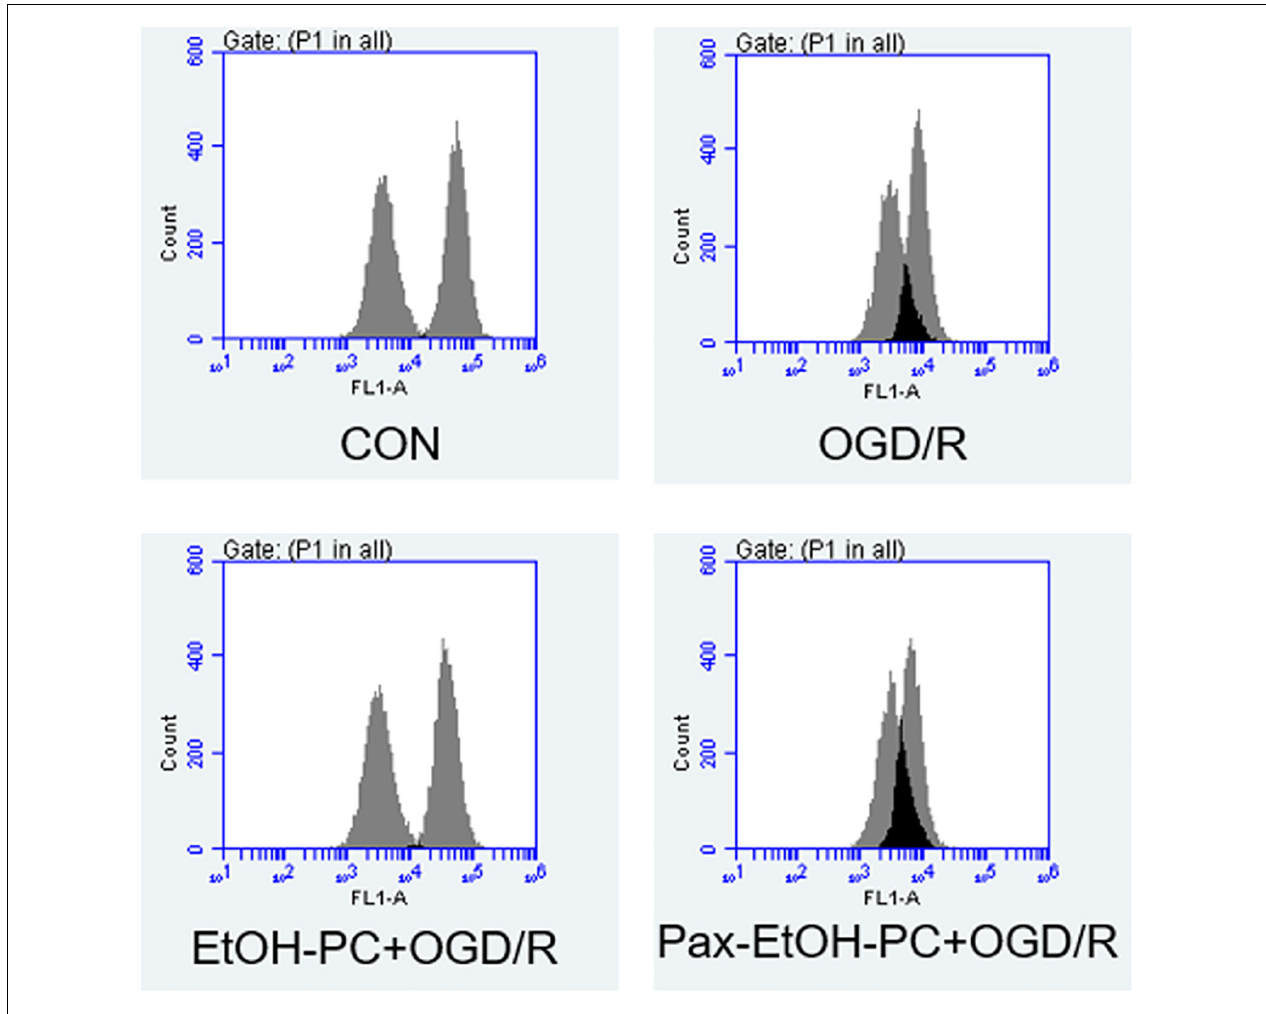
FIGURE 6 | Ethanol preconditioning regulated the mitochondrial permeability transition pore during OGD/R. The neuron cells were preincubated with paxilline (5 µ mol/L) for 10 min and preconditioned with ethanol (10 mmol/L) followed by OGD2h/R24h. The mitochondrial potential was determined by mitochondrial permeability transition pore (MPTP)